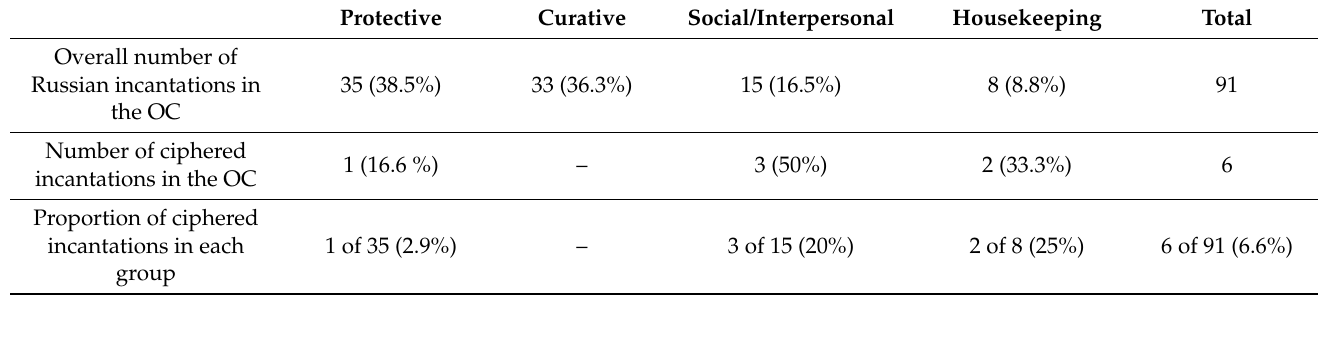
Table 2. Statistic of ciphered Russian incantations in the OC.